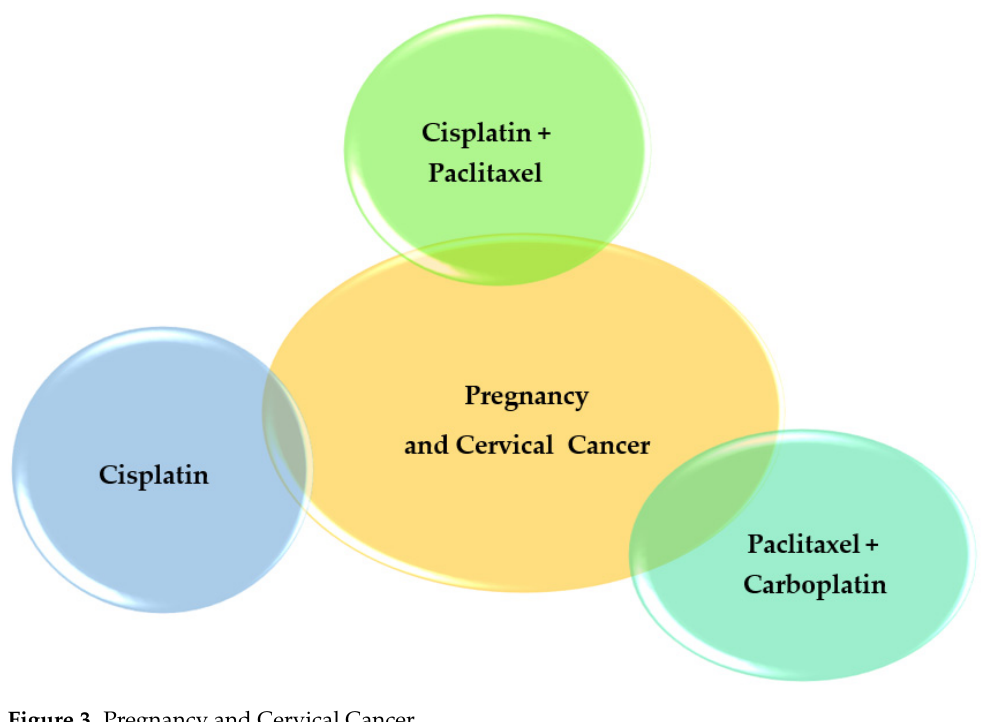
Figure 3. Pregnancy and Cervical Cancer.